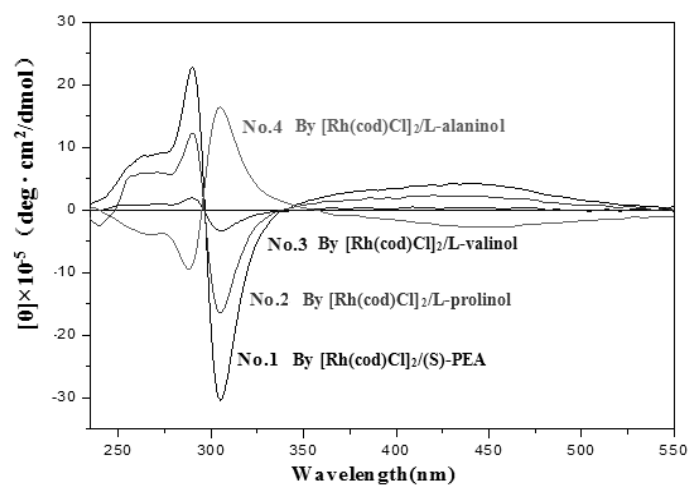
Figure 3. CD spectra of chiral poly( DoDHPA ) obtained using the [Rh(cod)Cl] 2 /(chiral amine) catalytic system (CD spectra were determined in a THF solution with 1.000 mmol/L poly( DoDHPA )) (Table 1, entries 1–4).